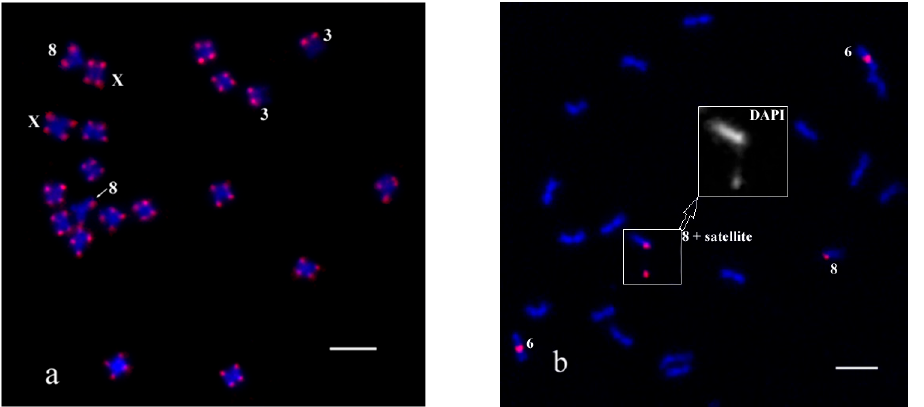
Figure 1. The results of FISH experiments with the PCR labelled probes CS-1 and CS-237 on C. sativa chromosomes: ( a ) pink—CS-1 probe; ( b ) pink—CS-237 probe. DAPI layer of chromosome 8 with satellite is enlarged and shown in gray. Distinguished chromosomes are indicated according to Alexandrov et al. [31]. Bar equals 5 μ m.